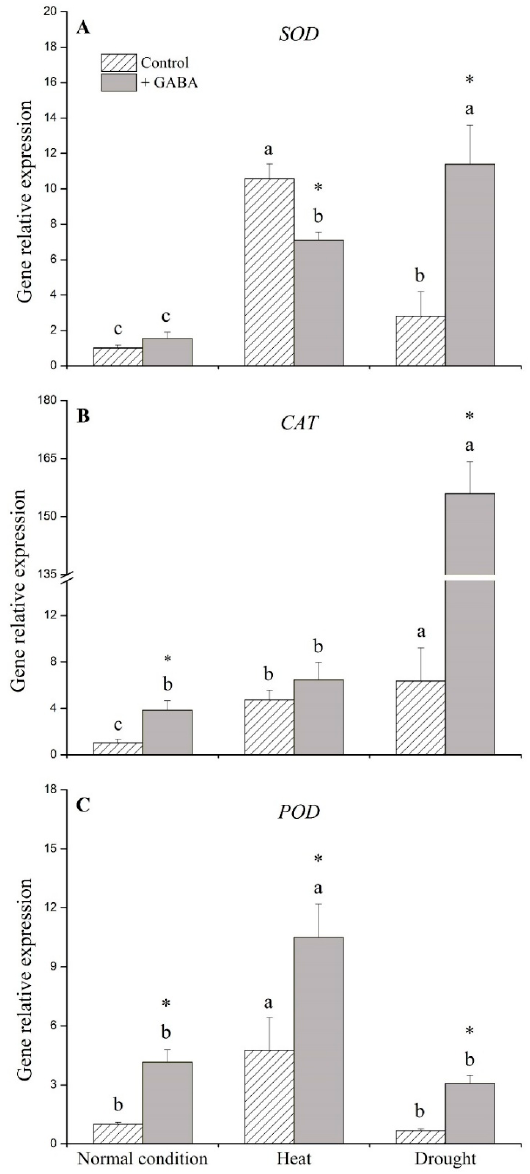
Figure 6. Effects of γ -aminobutyric acid (GABA) on genes’ expression of ( A ) superoxide dismutase ( SOD ), ( B ) catalse (CAT ), and ( C ) peroxidase ( POD ) under normal, heat, and drought conditions. Vertical bars indicate ±SE of mean ( n = 4). Different letters above columns indicate significant differences for one particular treatment (control or +GABA) under different conditions; asterisk “*” indicates significant difference between control and +GABA treatment under a given condition.